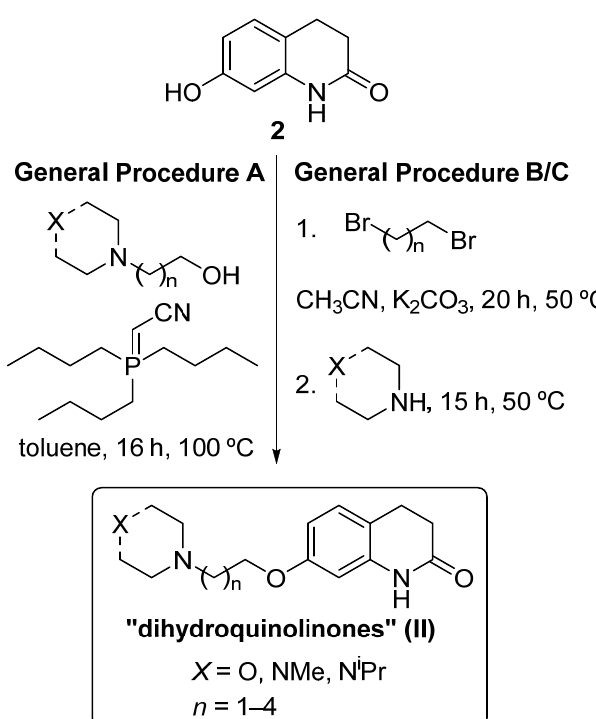
Scheme 2. Synthetic methods for the preparation of the “dihydroquinolinones” ( DQN1 - 13 As described in the Materials and Methods section, starting from commercial 7 ‐ hydroxyquinolin ‐ 2(1 H ) ‐ one ( 1 ) and the appropriate aminoalcohol, compounds QN6 (10%), QN10